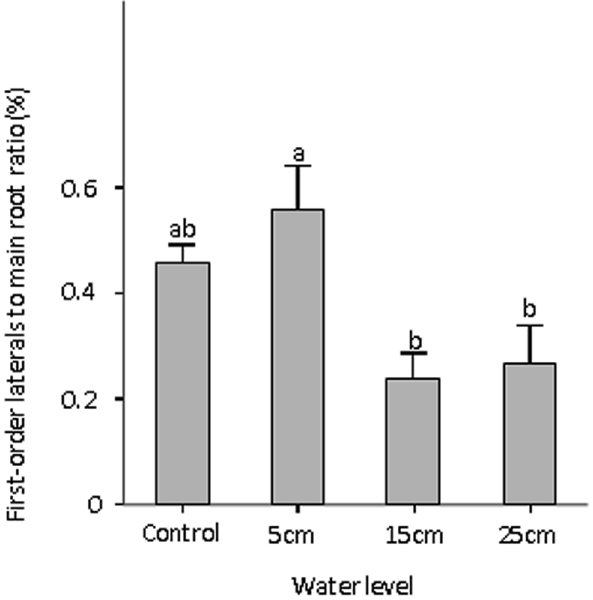
Fig 3. First-order laterals to main roots ratio (%) of Carex schmidtii in different treatments (one control: 0 cm water level, and three submerged conditions: 5 cm, 15 cm, and 25 cm water level). Different letters indicate significant differences among treatments ( P <